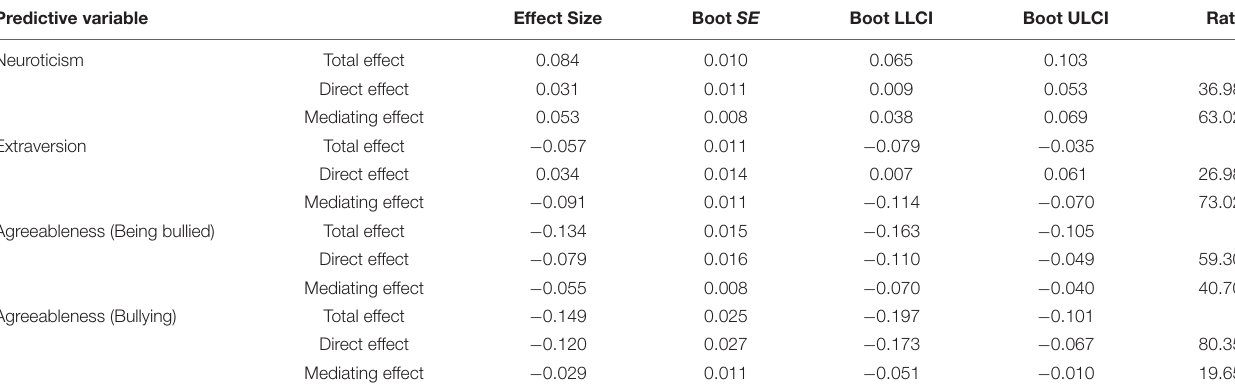
TABLE 3 | Decomposition of the total, direct and mediating effects.